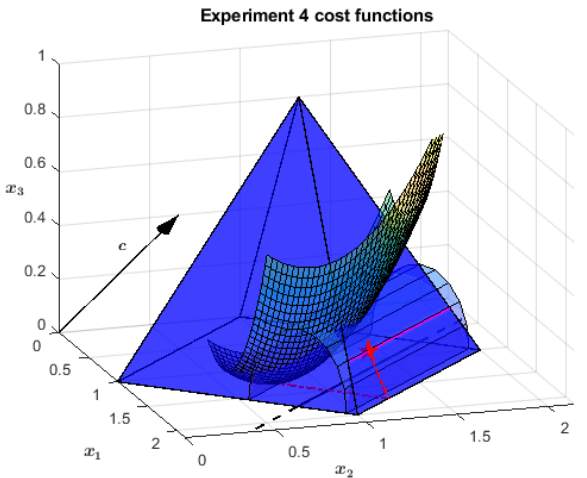
Figure 7. Cost functions: the primary objective is the vector c ; the secondary one is the distance from the black line on the x 1 x 2 axis (the cylinder is a level surface); the tertiary one is the infinite paraboloid centered on ( 5 , 3 , 0 ) . 4 4